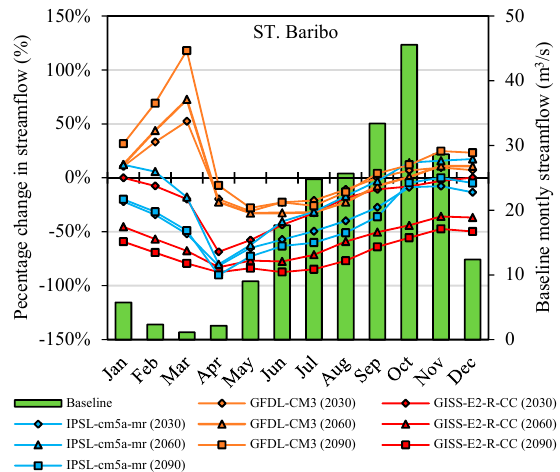
Figure A3. Baseline monthly streamflows and percent changes in mean monthly river flows from baseline for the 2030s, 2060s and 2090s climate change scenarios.